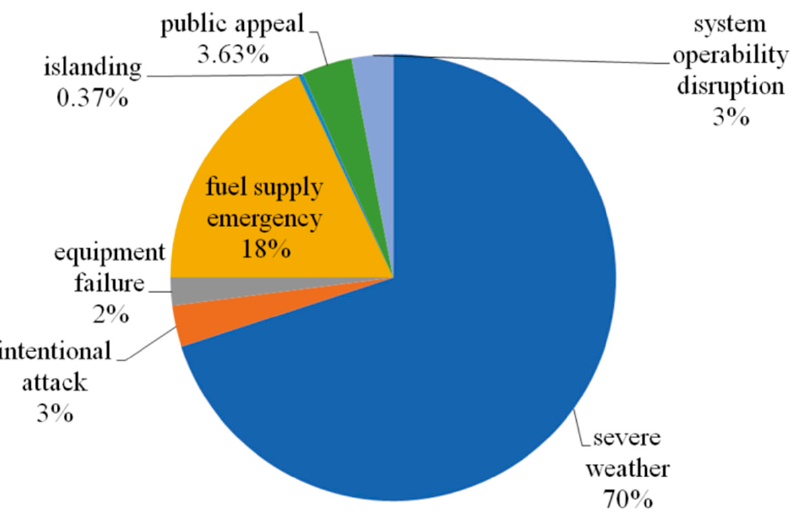
Figure 7. Revenue loss in percentage due to seven kinds of events that caused power outages in the U.S.